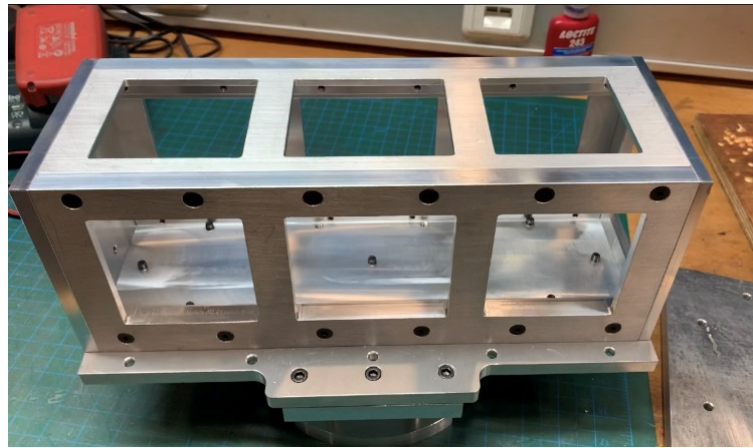
Figure 19. Test pod mounted on the head expander.